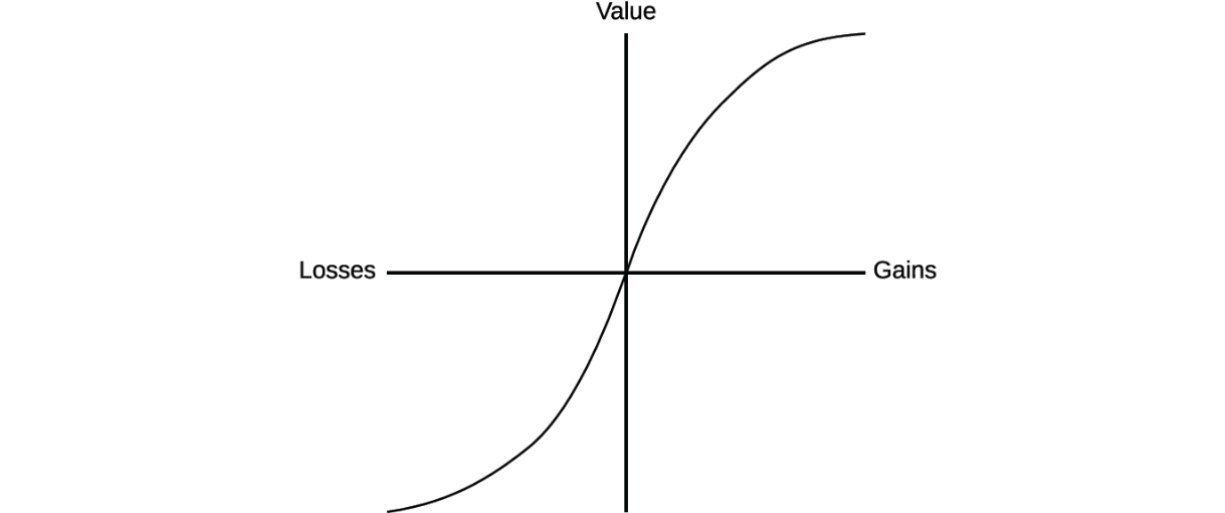
Figure 1. Schematic representation of decision framing in terms of gains and losses (adapted from Tversky and Kahnamen